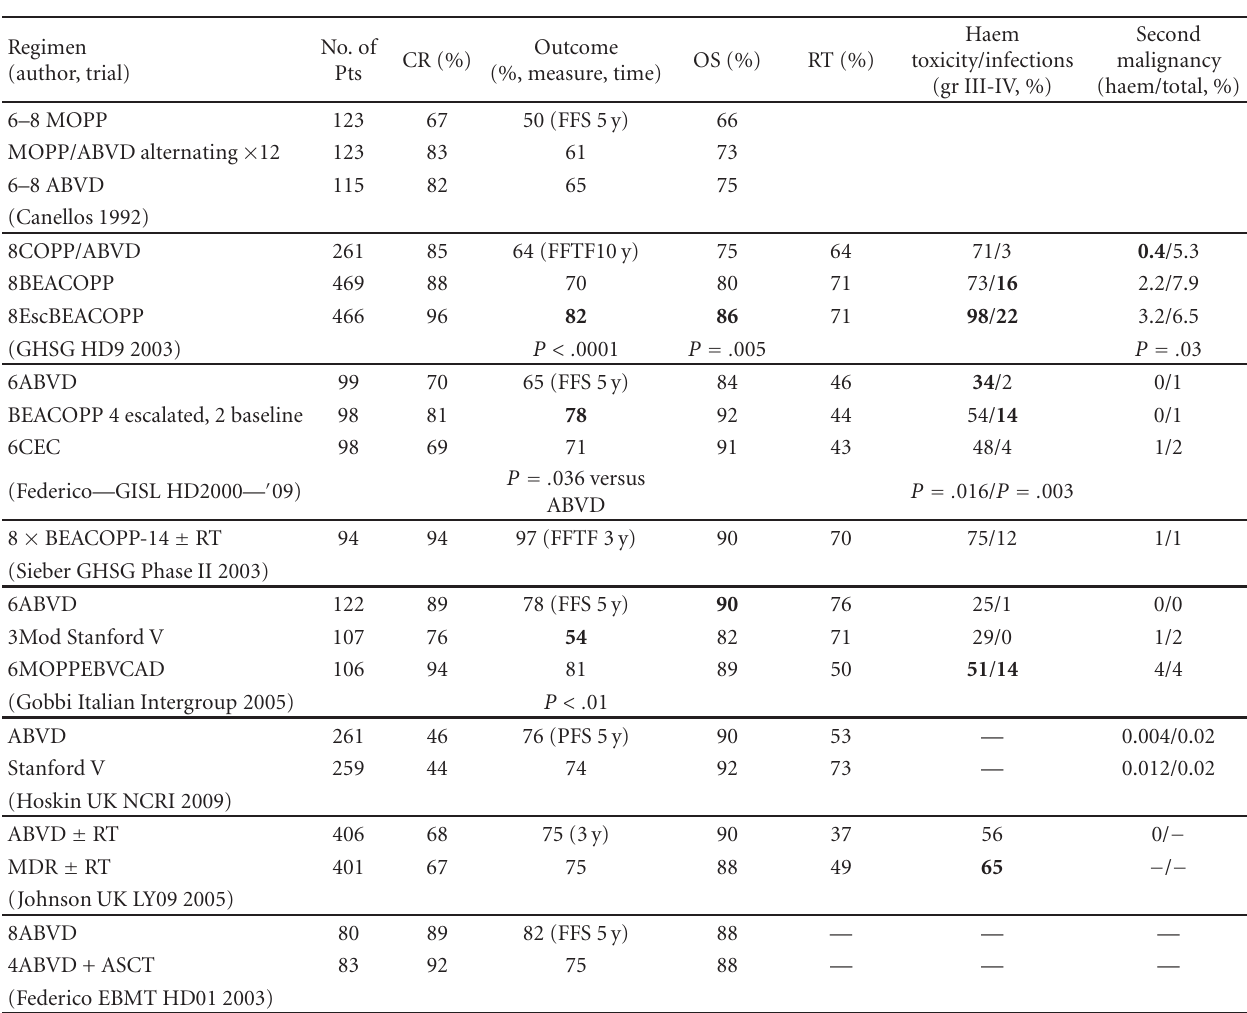
Table 6: Trials of treatments currently under investigation for the treatment of advanced stage Hodgkin disease. Numbers in bold are statistically significant with P values where significant. Abbreviations: OS: overall survival; RT: radiotherapy; MOPP: mechlorethamine, vincristine, procarbazine, and prednisolone; ABVD: doxorubicin, bleomycin, vinblastine, and dacarbazine; COPP/ABVD: cyclophosphamide, vincristine, procarbazine, and prednisolone/ABVD; BEACOPP: bleomycin, etoposide, doxorubicin, cyclophosphamide, vincristine, procarbazine, and prednisolone; CEC: cyclophosphamide, lomustine, vindesine, melphalan, prednisolone, epidoxorubicin, vincristine, procarbazine, vinblastine, and bleomycin; Stanford V: doxorubicin, vinblastine, mechlorethamine, vincristine, bleomycin, etoposide, and prednisolone; MOPPEBVCAD: mechlorethamine, vincristine, procarbazine, prednisolone, epidoxorubicin, bleomycin, vinblastine, lomustine, doxorubicin, and vindesine; MDR ChIVPP: (chlorambucil, vinblastine, procarbazine, and prednisolone) alternating either with PABIOE (prednisolone, doxorubicin, bleomycin, vincristine, and etoposide) or EVA (etoposide, vincristine, and doxorubicin); ASCT: autologous stem cell